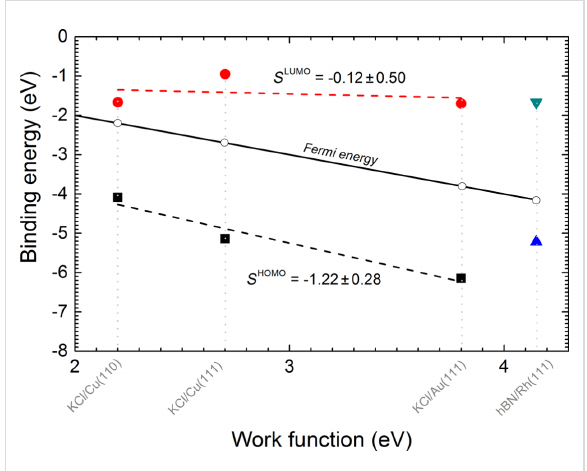
Figure 8: Experimentally determined energies for E a (red circles) and E i (black squares) of pentacene versus the work function of the respective KCl/metal substrates. Separately indicated are the values for h-BN/Rh(111). Dashed lines indicate linear fits of E a and E i . The open circles indicate the position of the Fermi energy (black line is a linear fit to these values).